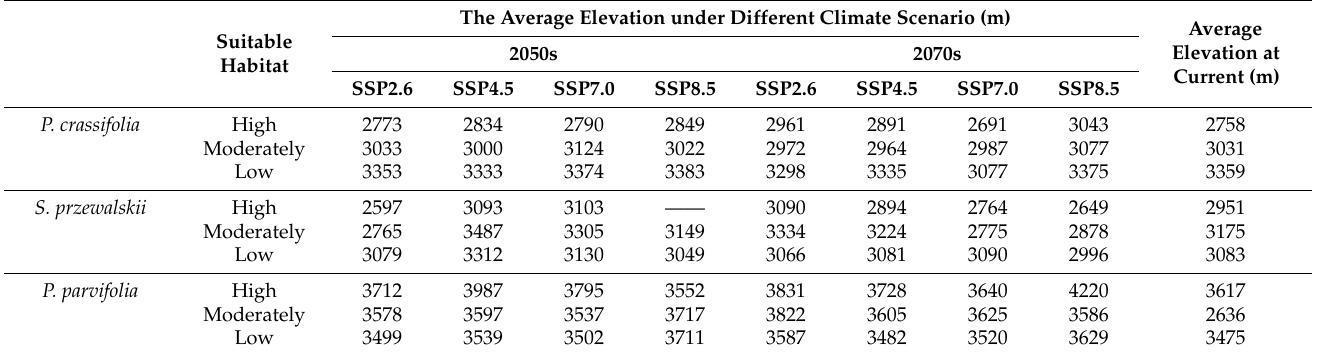
Average Elevation